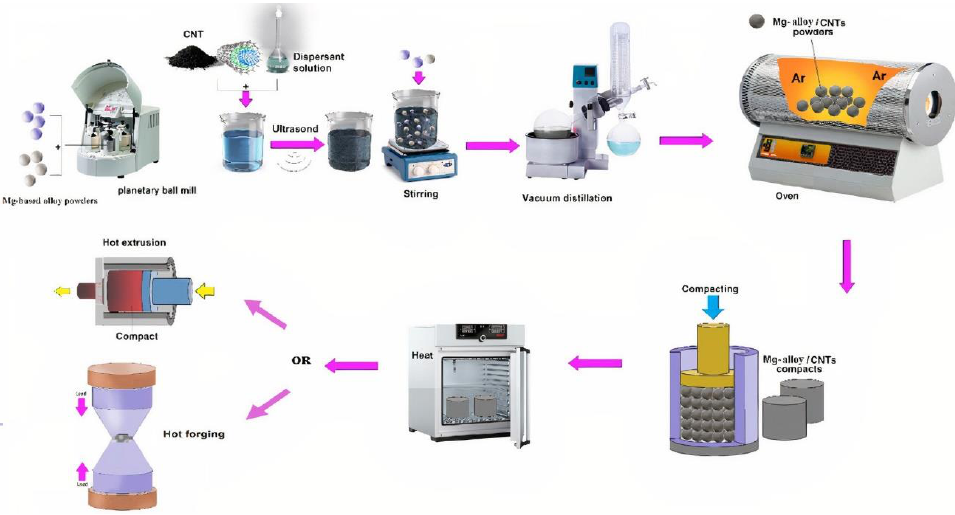
Figure 4. Processes included in the gemini dispersant for fabricating Mg-CNT composites